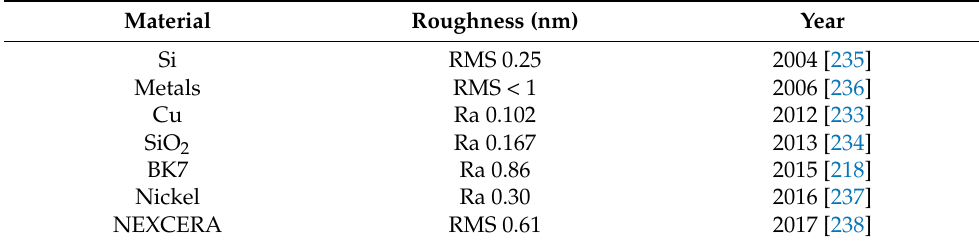
Table 9. The ultimate roughness achieved with MRF for different